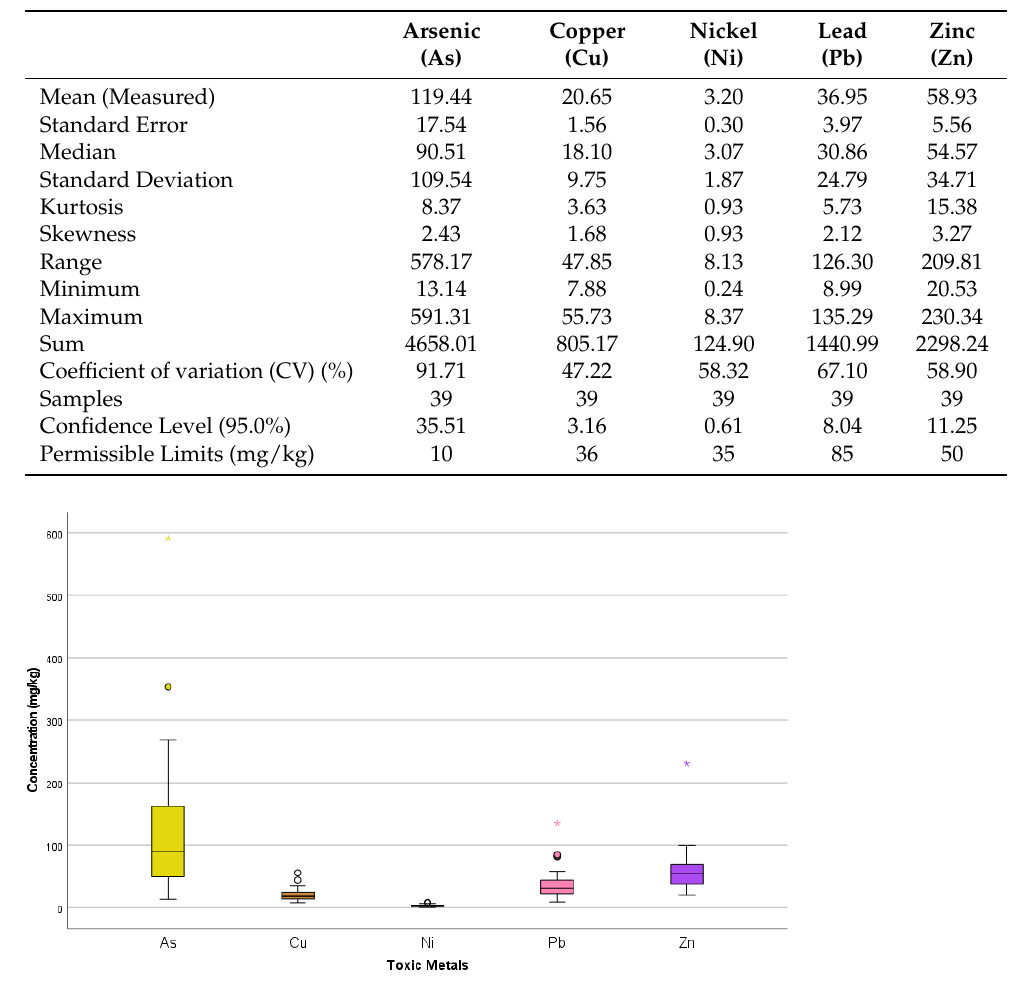
Table 3. Descriptive statistics for selected toxic metals from soil samples.